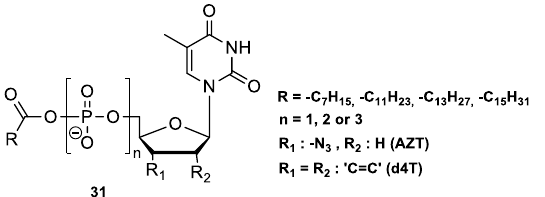
Figure 5. Examples of nucleoside mono-, di-, and triphosphate pronucleotides with a structural motif of the mixed carboxylic – phosphoric anhydrides [103,104].